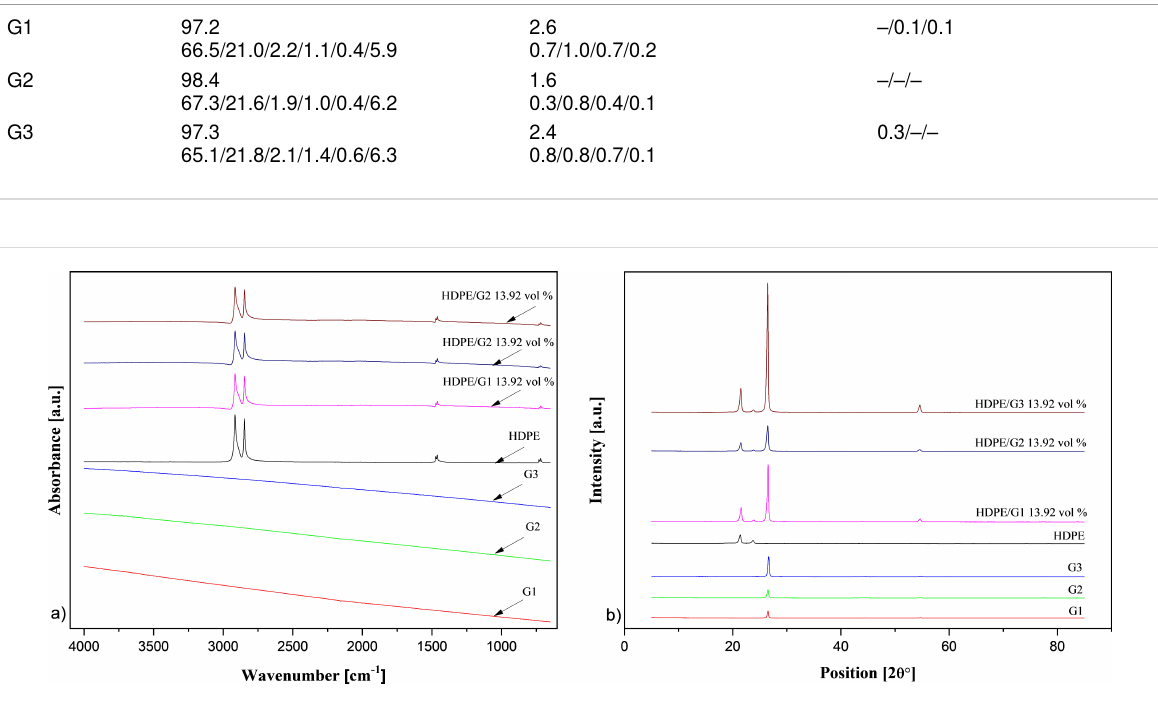
Table 1: Apparent surface chemical composition of GnPs, as determined by XPS. sample surface chemical composition (atom %)